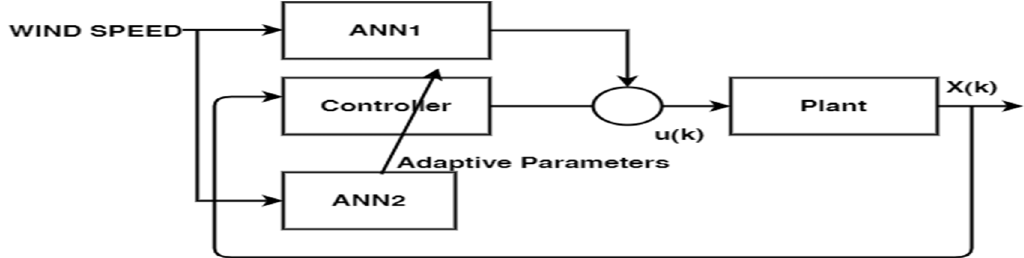
Figure A3. block diagram of ANN-LQG controller. Figure A3. Block diagram of ANN-LQG controller.